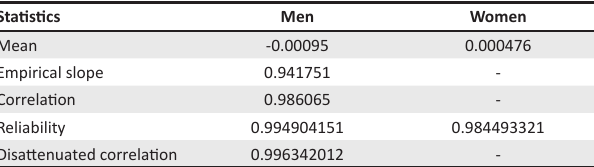
TABLE 4: Differential test functioning statistics for the male and female groups for English Comprehension Test version 1.3.